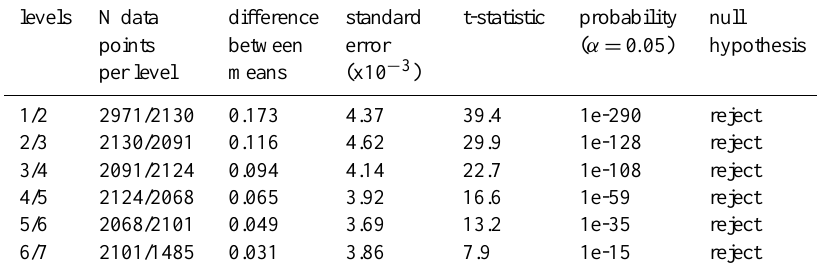
t-statistic probability standard difference ( α = 0 . 05) error between (x10 − 3 ) means